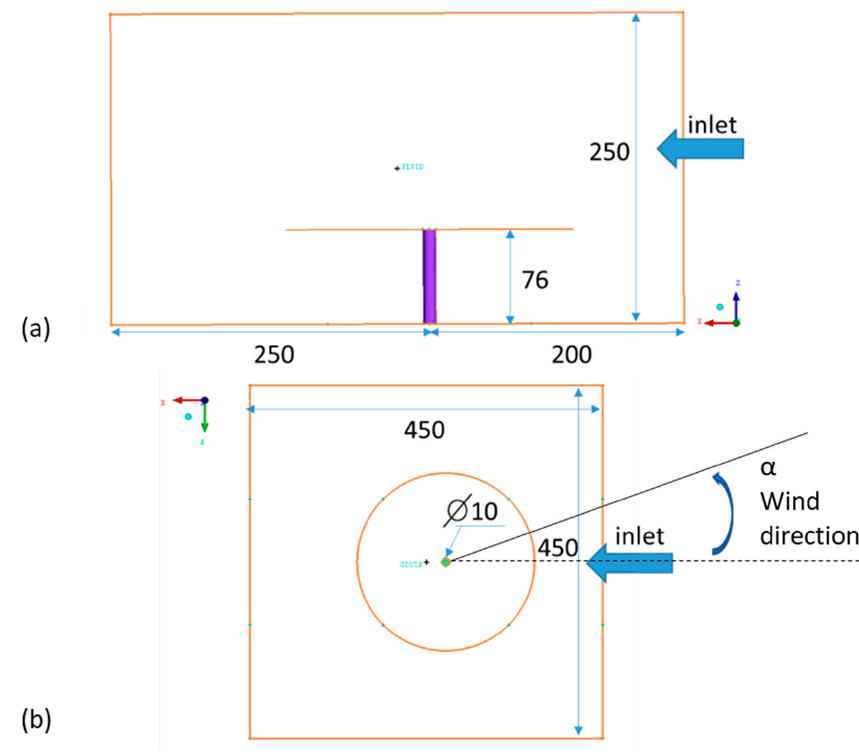
Figure 1. Fluid domain geometrical dimensions (mm)—( a ) side view and ( b ) top view.